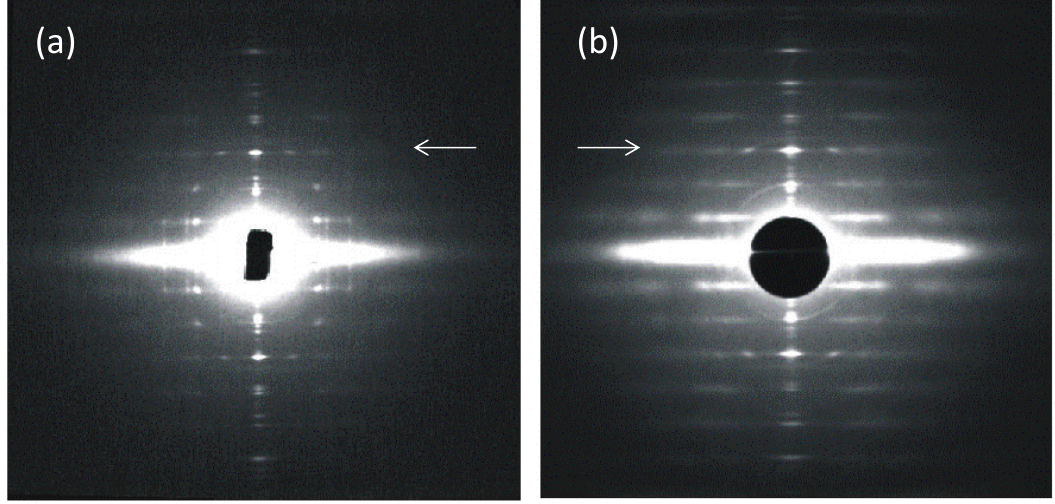
Figure 2. ( a , b ) Low-angle X-ray diffraction patterns from fish muscle ( a ) and frog muscle ( b ) (courtesy of Hugh Huxley and Tom Irving), showing the similar layer-line (horizontal line) distribution, but different sampling along the layer lines. The arrows point to the meridional (M3) peak at 14.3 nm. ( c , d ) Summary of the X-ray patterns. The sampling in the fish muscle X-ray pattern ( a , c ) is very regular (sampling on all layer lines is on the same vertical row lines) indicating the presence of a simple lattice. Sampling in the frog pattern ( b , d ) is different on different layer lines and shows a superlattice. ( c , d ) adapted from [10] with permission from